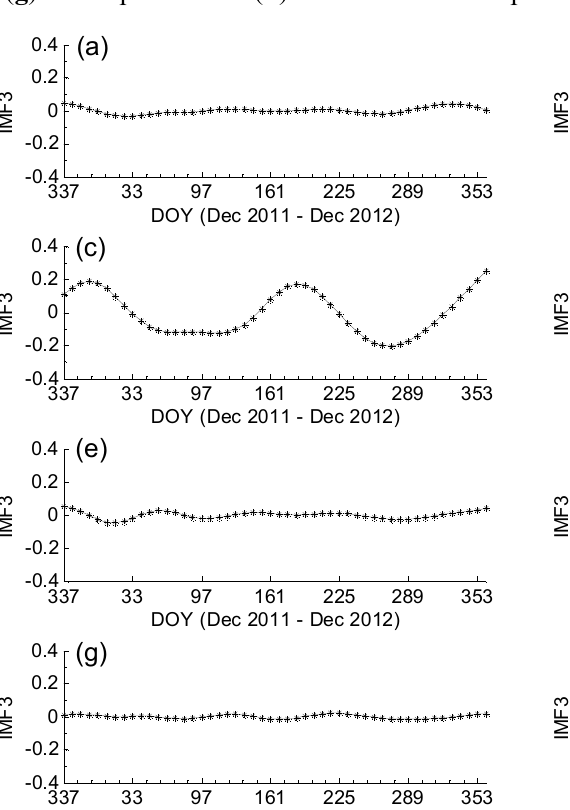
Figure 3. The IMF3 (intrinsic mode function) obtained from the empirical mode decomposition (EMD) sifting for different signals of land-use types in the study area: ( a ) single-cropped rain-fed rice, ( b ) double-cropped irrigated rice, ( c ) double-cropped rain-fed rice, ( d ) triple-cropped irrigated rice, ( e ) orchards/fruit trees, ( f ) forests, ( g ) built-up areas and ( h ) water bodies/shrimp